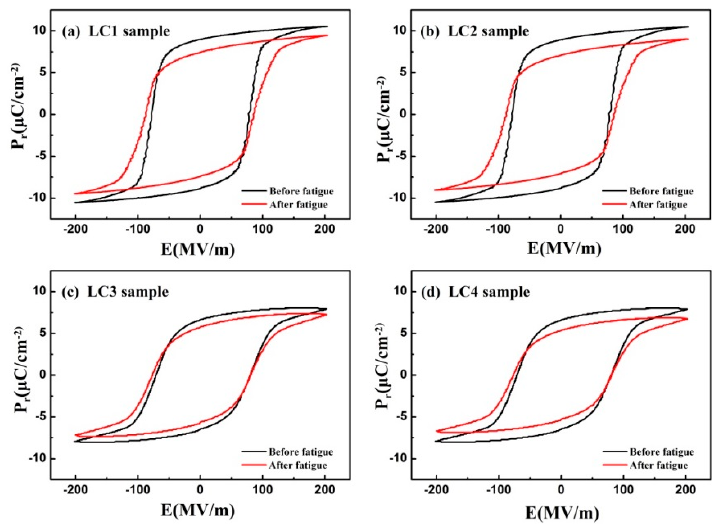
Figure 2. The P–E hysteresis loops of LC1–LC4 measured at 25 °C. The solid lines in black denote the hysteresis loops before fatigue, and the solid lines in red denote the hysteresis loops after fatigue.